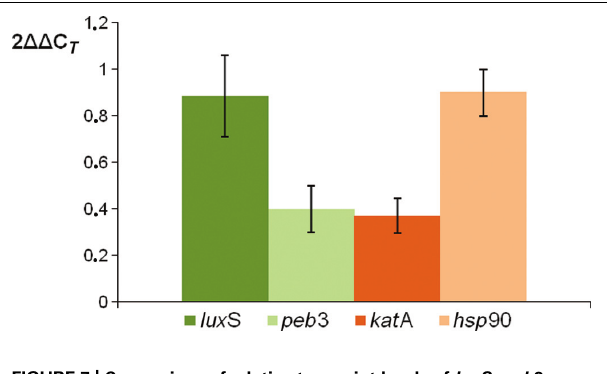
FIGURE 7 | Comparison of relative transcript levels of lux S, peb 3, kat A, and hsp 90 genes between C. jejuni pnp mutant and the parental strain, assessed by quantitative RT-PCR. Each bar represents relative expression level of a gene in the mutant strain according to the 2 (cid:2)(cid:2) C T method described by Livak and Schmittgen (2001).The internal reference gene used was rpo A and the calibrator condition was the expression in the wild-type strain (equivalent to 1). Each value is the mean of at least three independent RNA extractions and error bars indicate the standard deviations.